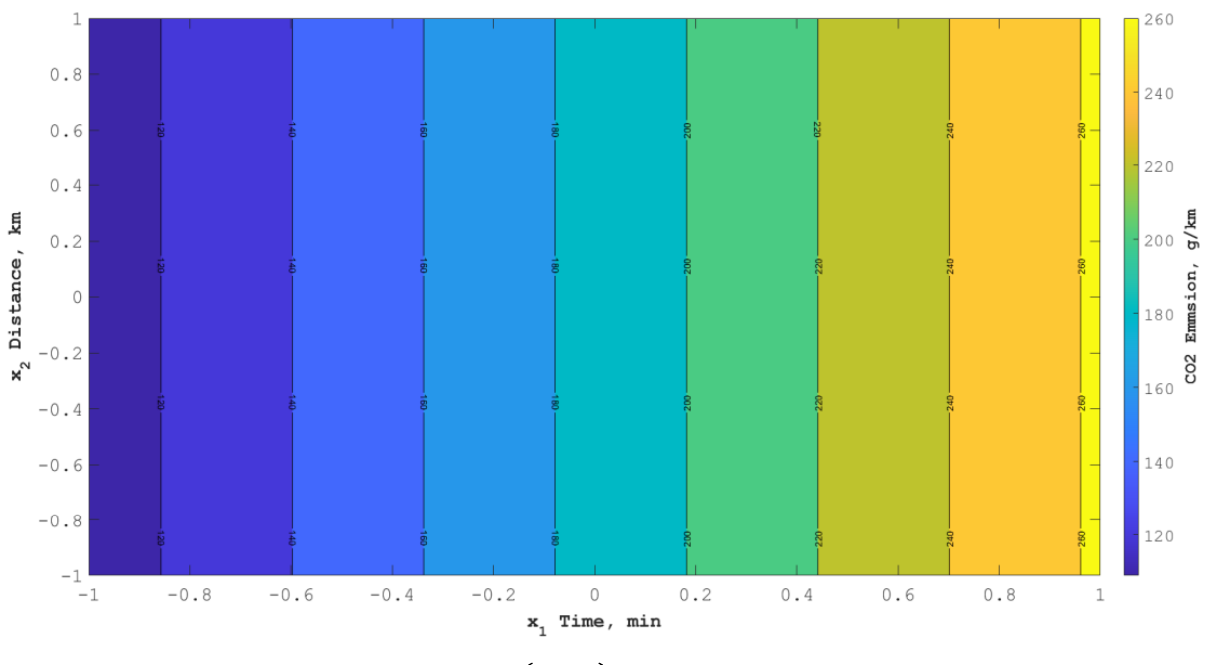
Figure 18. Change in CO 2 emissions depending on the variability of factors x 1 and x 2 for a vehicle (EV) moving at a temperature of 20 °C (x 3 = 0).